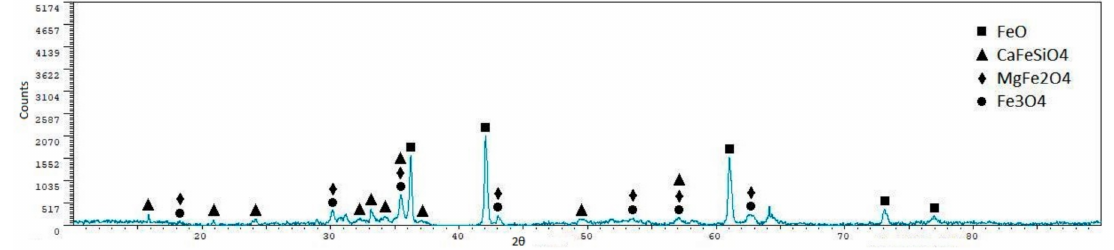
Figure 4. X-ray diffraction pattern of the sample Sint2.